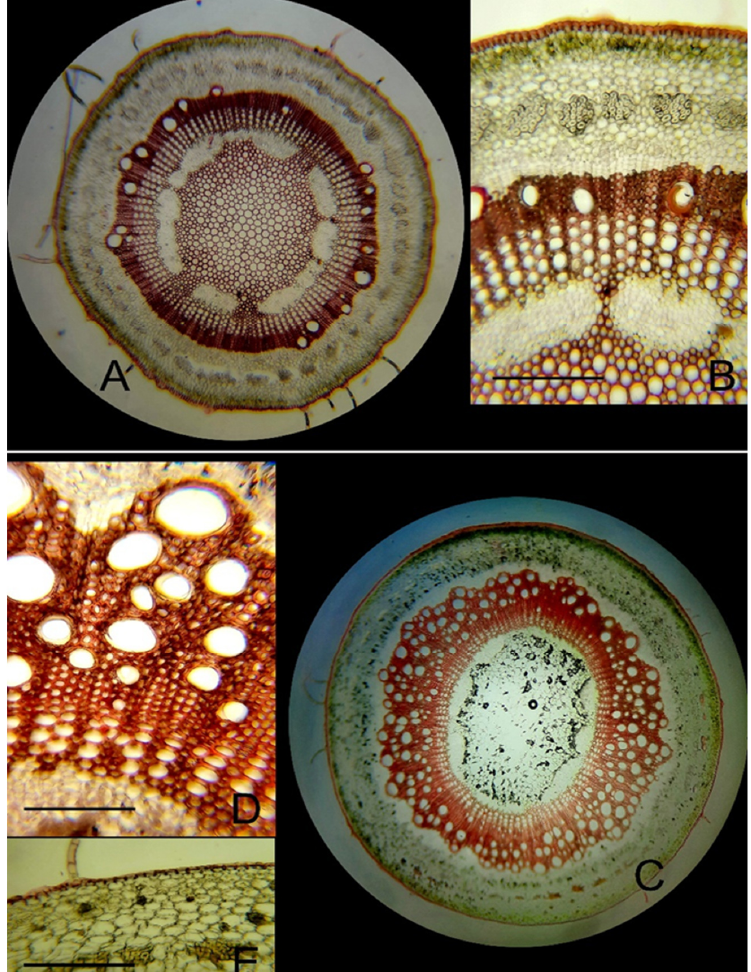
Figure 5.A. Abnormally behaving cambium below phloem wedges producing secondary xylem tracheids towards inner side, B. Close up of secondary xylem beginning to fill the wedges. C. Mature stem with round outline and no sign of abnormality. D. Close up of wedges completely filled in by Sec. Xylem. E. Collapsing of gelatinous fibres upon maturity of stem. Scale bar: 400 µ (B), and 100µ (D,